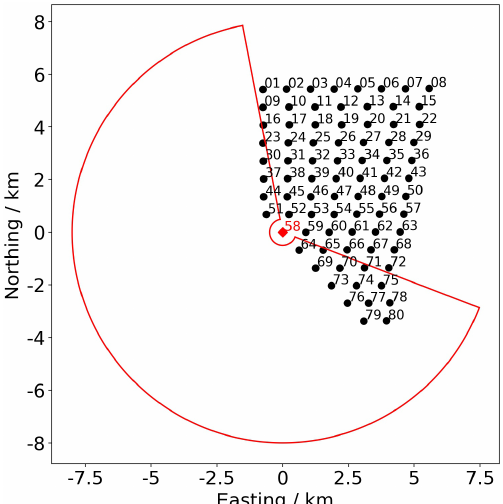
Figure 2. Layout of the wind farm Global Tech I with turbine num- bers. The turbine GT58, where we positioned the lidar, is marked in red ( (cid:5) ). The achievable sector for lidar measurements is